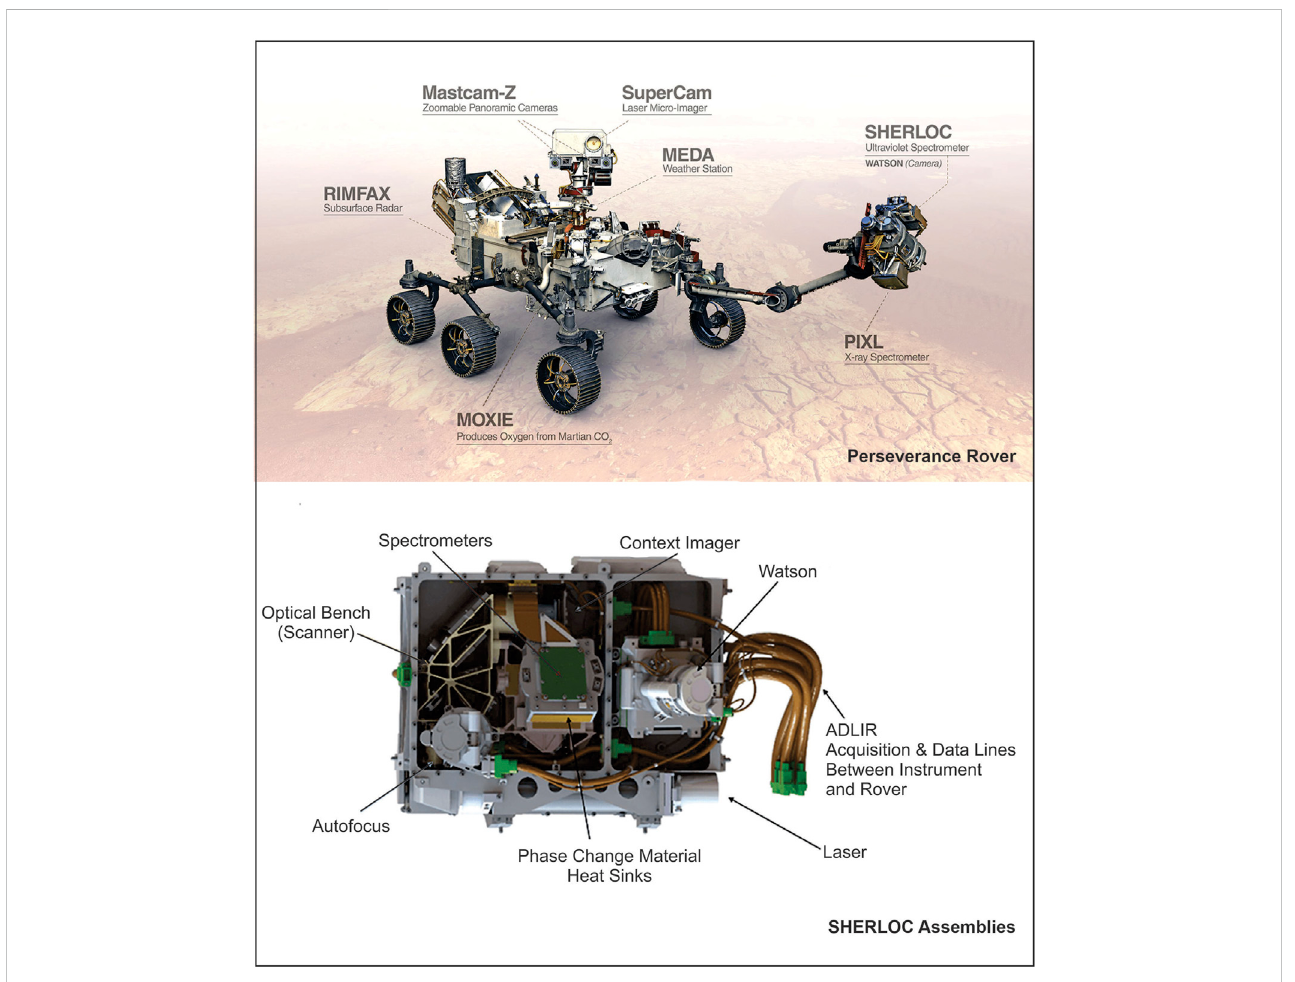
FIGURE 4 Perseverance Rover and SHERLOC instruments [Huidobro et al. (2022) and NASA